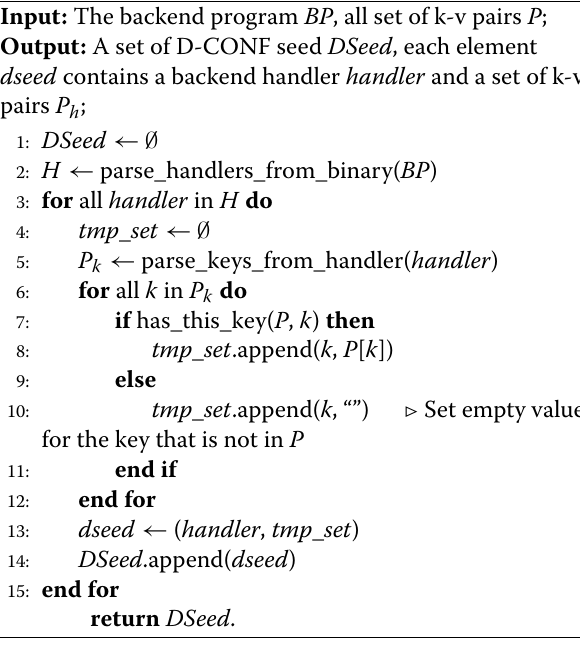
Algorithm 2 Algorithm for D-CONF Seed Generation. Algorithm 3 Mutation Algorithm for each